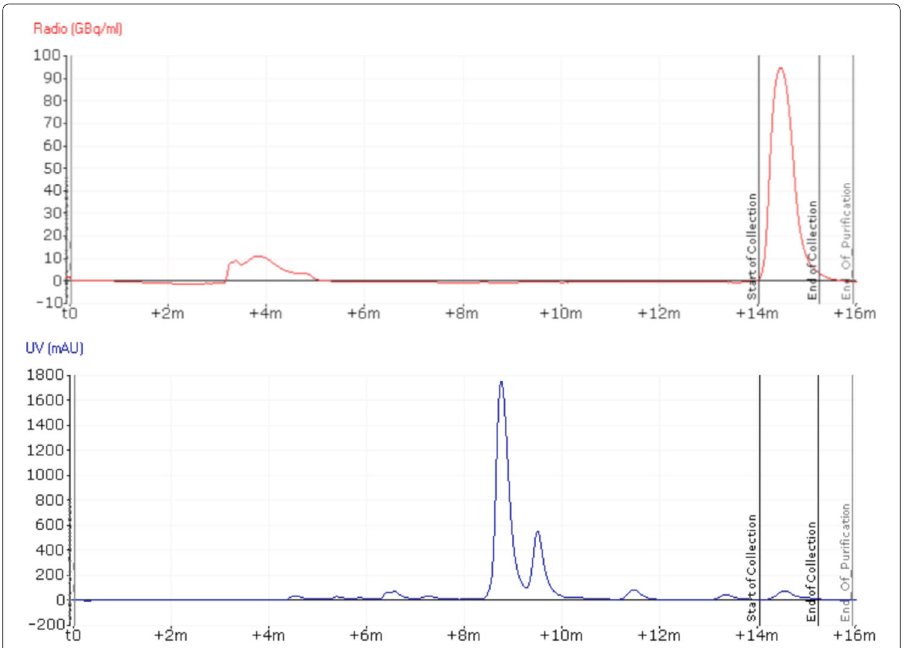
Fig. 4 HPLC purification chromatogram of a [ 18 F]DPA-714 production on the Trasis. Upper trace: Radioactivity. Note: the scale is not calibrated, so radioactivity values are not accurate. Lower trace: UV measurement, λ = 254 nm